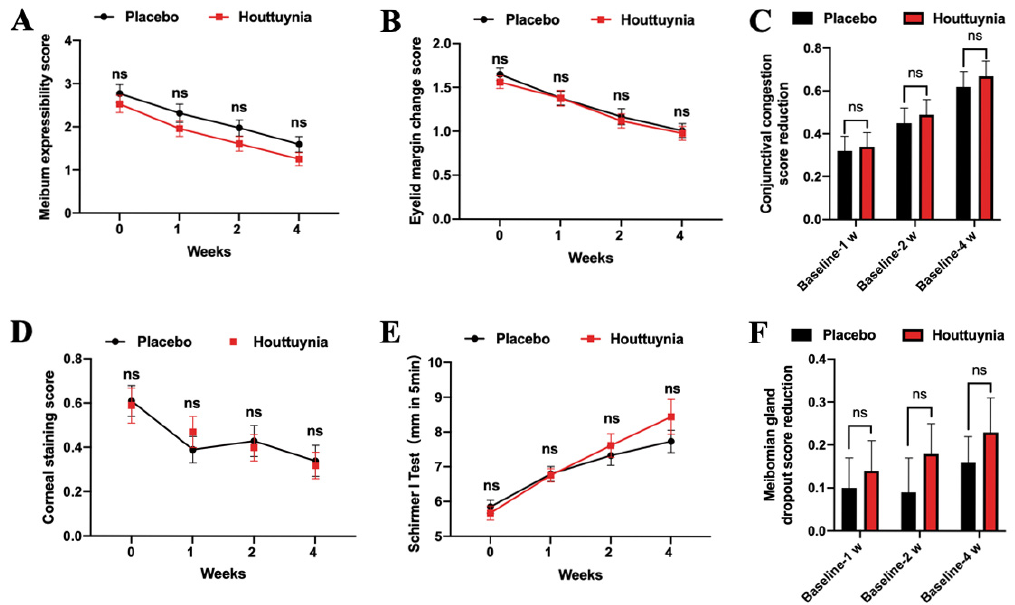
Figure 4. Changes in secondary outcome measures. ( A ), ( B ), ( D ), and ( E ) illustrate meibum expressibility scores, eyelid margin change, corneal staining, and Schirmer I test results, respectively. These data are shown at baseline as well as after one week, two weeks, and four weeks. ( C , F ) show reduction values for conjunctiva congestion and meibomian gland dropout scores after one week, two weeks, and four weeks compared with the baseline. Data at each point are presented as mean ± SEM. ns, no